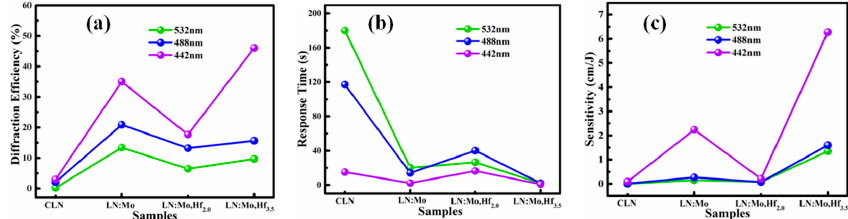
Figure 1. Photorefractive properties of Lithium niobate (LN): Mo crystals co-doped with different concentrations of Hf with a light intensity of 400 mW/cm 2 per beam at laser wavelengths of 532, 488, and 442 nm. Control LN (CLN) crystal is also presented for comparison. ( a ) Diffraction efficiency; ( b ) Response time; and ( c ) Sensitivity.